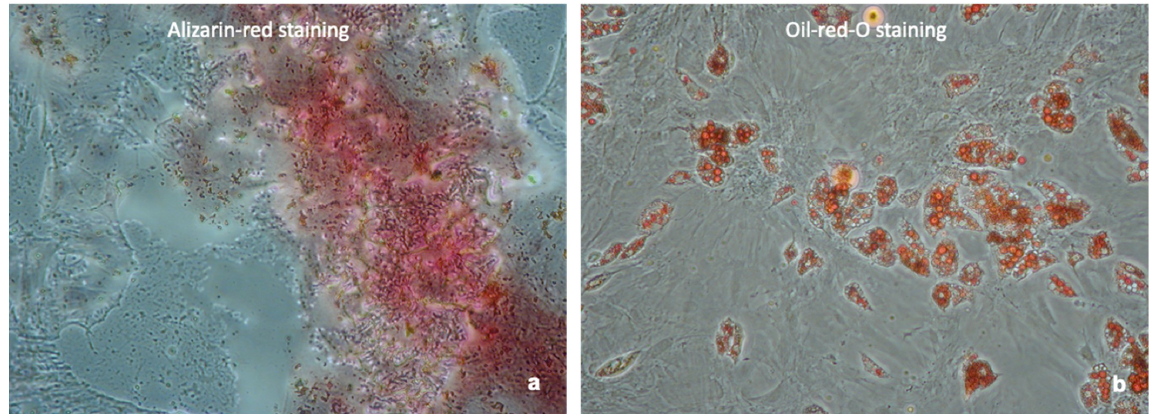
Figure A3. Confirmation of MSC differentiation into osteocytes and adipocytes. 10 × magnification of MSCs after stimulation with osteogenic and adipogenic differentiation media. Alizarin-red-staining for cells after osteogenic differentiation is shown in ( a ). Oil-red-O staining for adipocytes after differentiation is shown in ( b ).